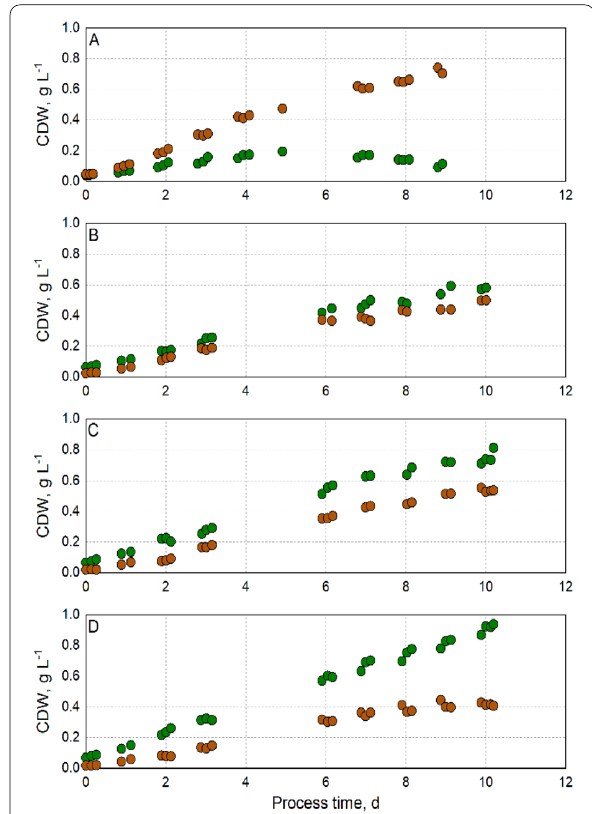
Fig. 4 Variation of inoculation ratios in phototrophic batch processes with T. lutea (red circle) and M. salina (green circle) in co‑culture at constant light irradiance of 83 17 µmol m − 2 s − 1 and a constant ± temperature of 25 °C in 200 mL bubble column reactors operated in parallel. A Inoculation ratio 1:1, B inoculation ratio 1:2, C inoculation ratio 1:3, D inoculation ratio 1:4 ( T. lutea : M. salina ). The batch processes were operated at a working volume of 200 mL and pH